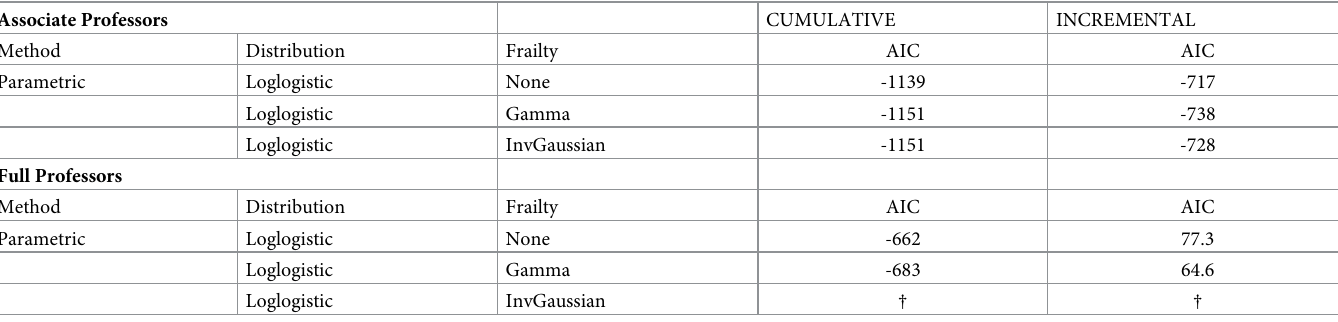
Table 3. Comparison of cumulative and incremental publication and time